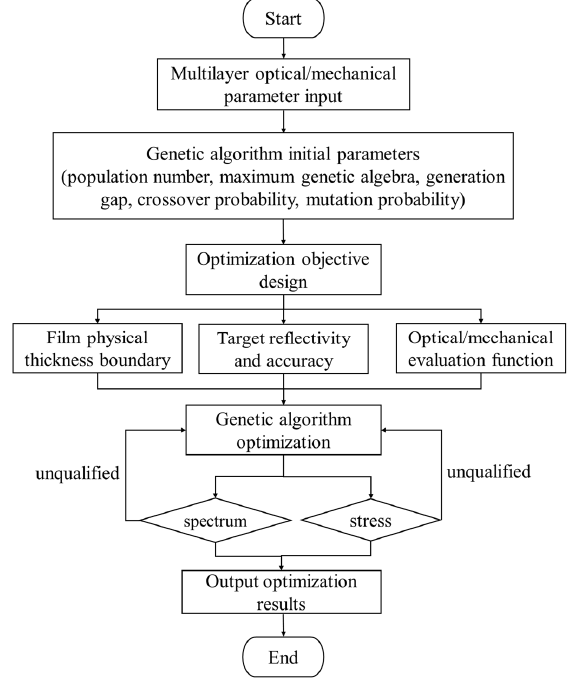
Figure 3. Flowchart of the film’s optical and mechanical compatible design.